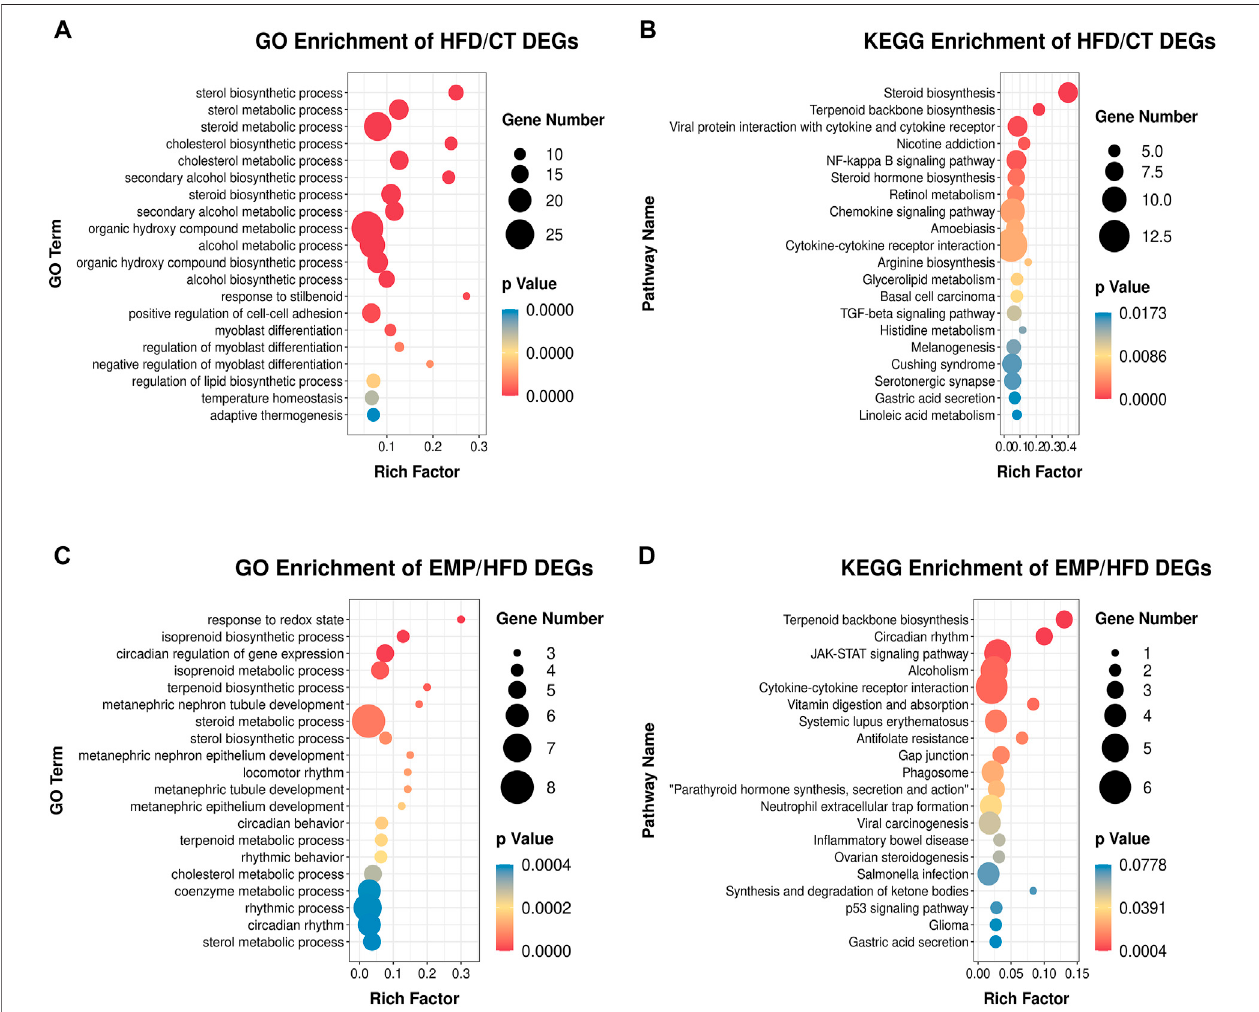
FIGURE 4 | Main GO terms and pathways enriched by DEGs between HFD and CT group, (A) GO terms; (B) KEGG pathways. Enrichment of GO and pathways basedonDEGsbetweenEMPandHFDgroup, (C) GOterms; (D) KEGGpathways.GeneNumberrepresentsthenumberofthedifferentialexpressedgenesenrichedin each